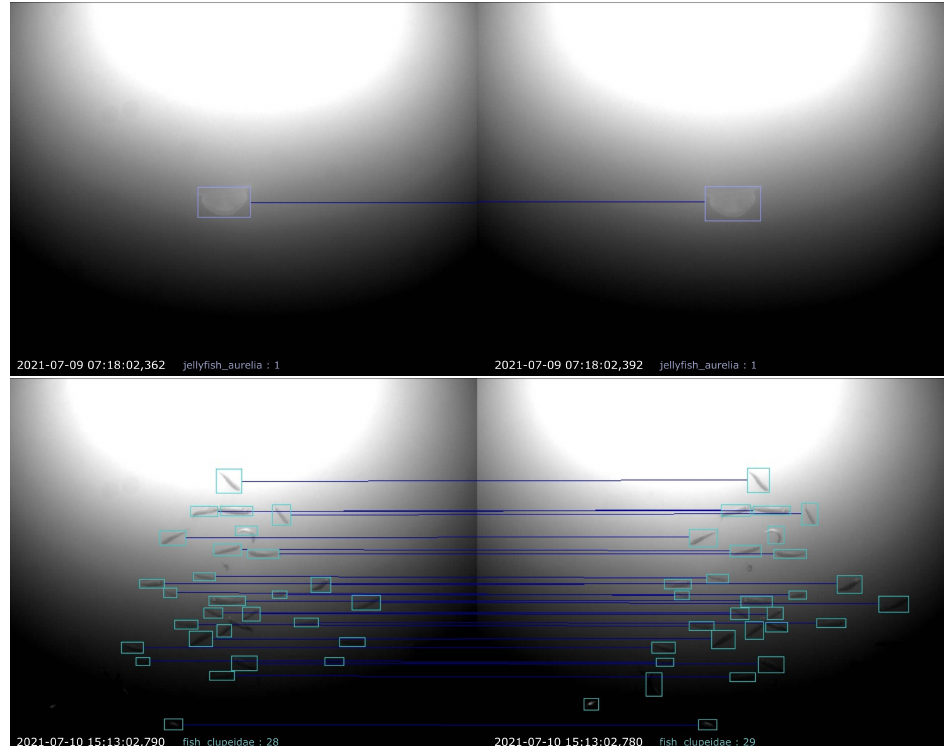
Figure 7. Exemplary results of the proposed matching procedure. Detected animals in both camera views are marked by colored bounding boxes, and boxes matched to each other are represented by horizontal lines drawn between